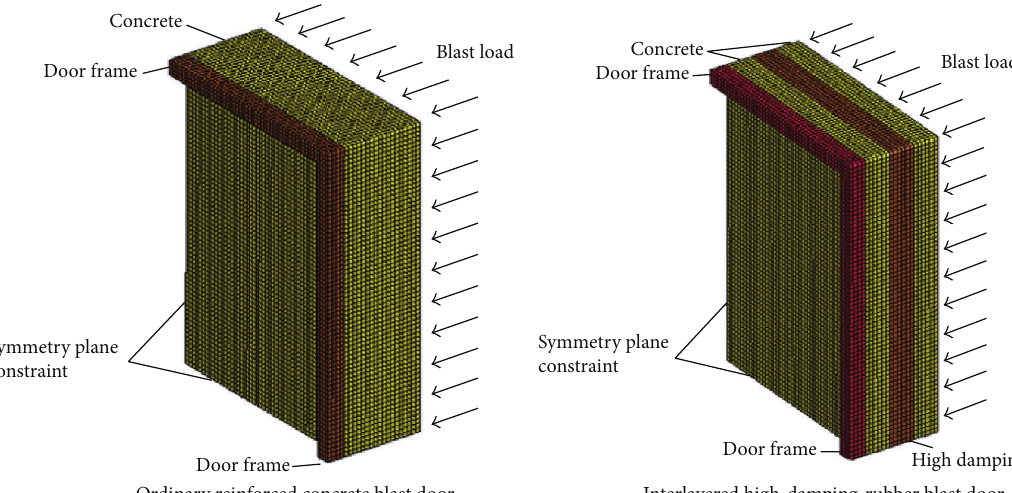
Figure 3: Finite element models of ordinary and interlayer blast